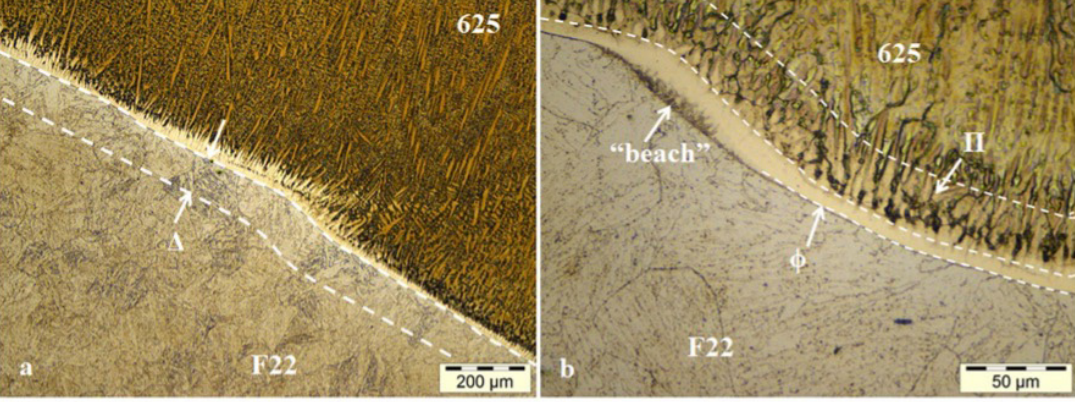
Figure 9. Microstructure of the buttering weld interface. (a) 100x. (b) 500x.